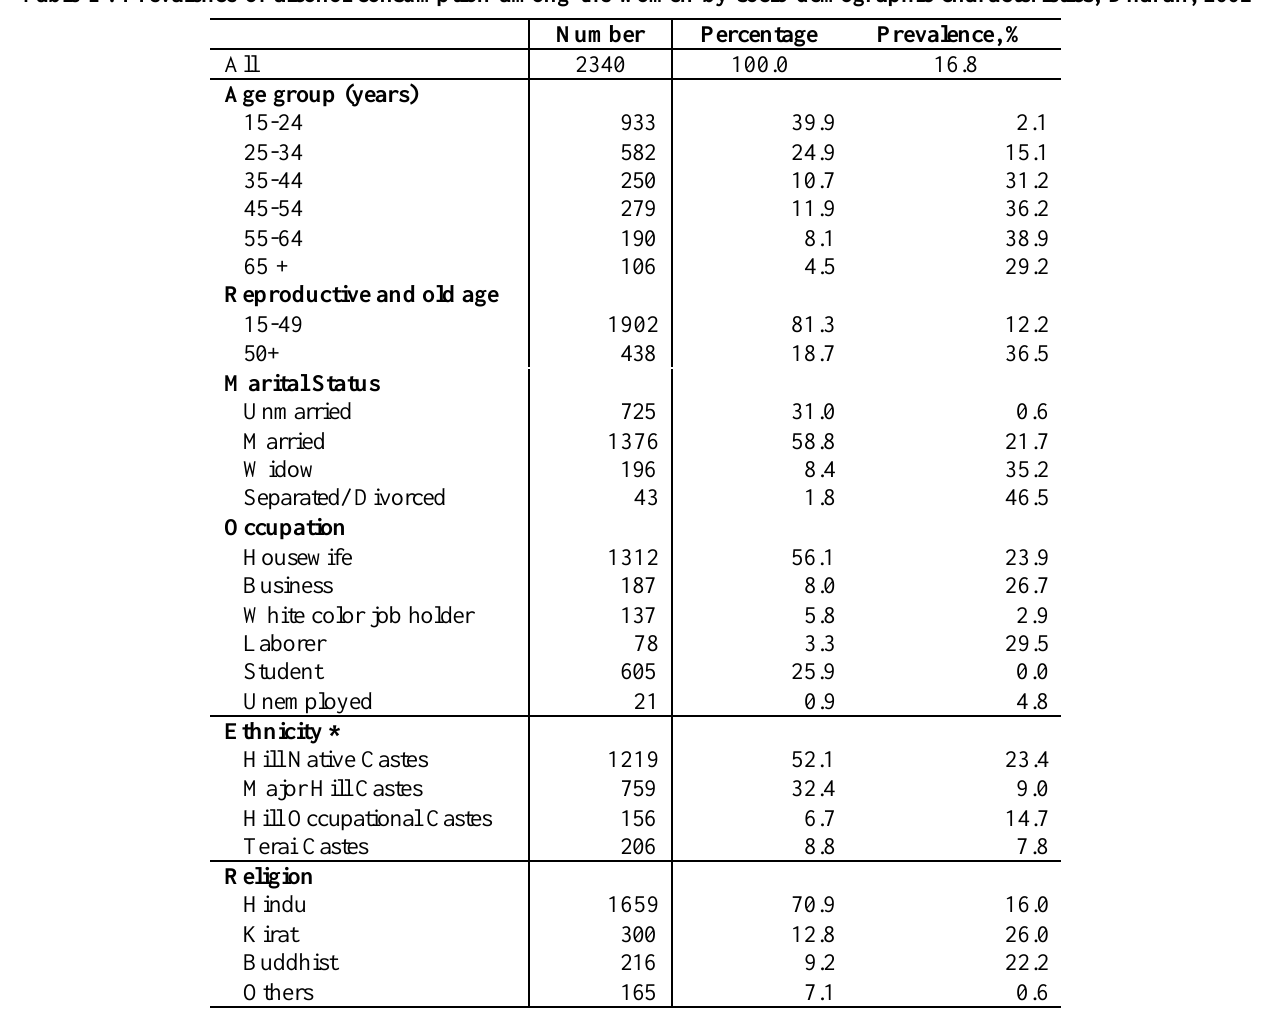
Table I : Prevalence of alcohol consumption among the women by socio-demographic characteristics; Dharan,